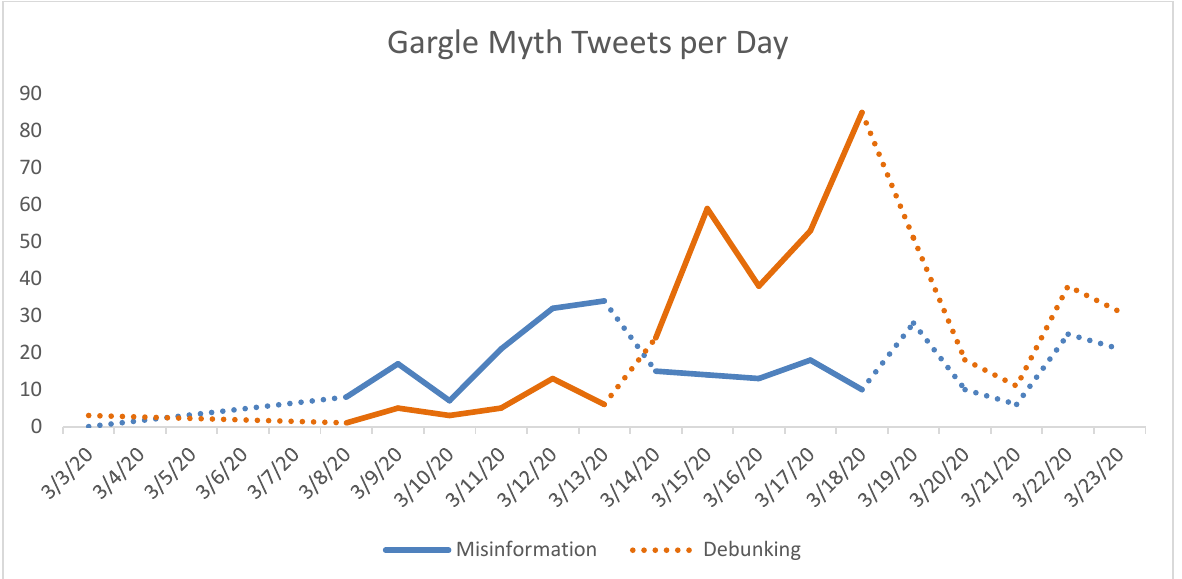
Figure 6. Gargle misinformation tweets vs. gargle debunking tweets over time. The solid line indicates the days when the difference in proportion between misinformation and debunking tweets was significant (p < .05) according to a Chi-square Test for Independence. The dotted line indicates the days when the proportion of the two types of tweets did not differ significantly.